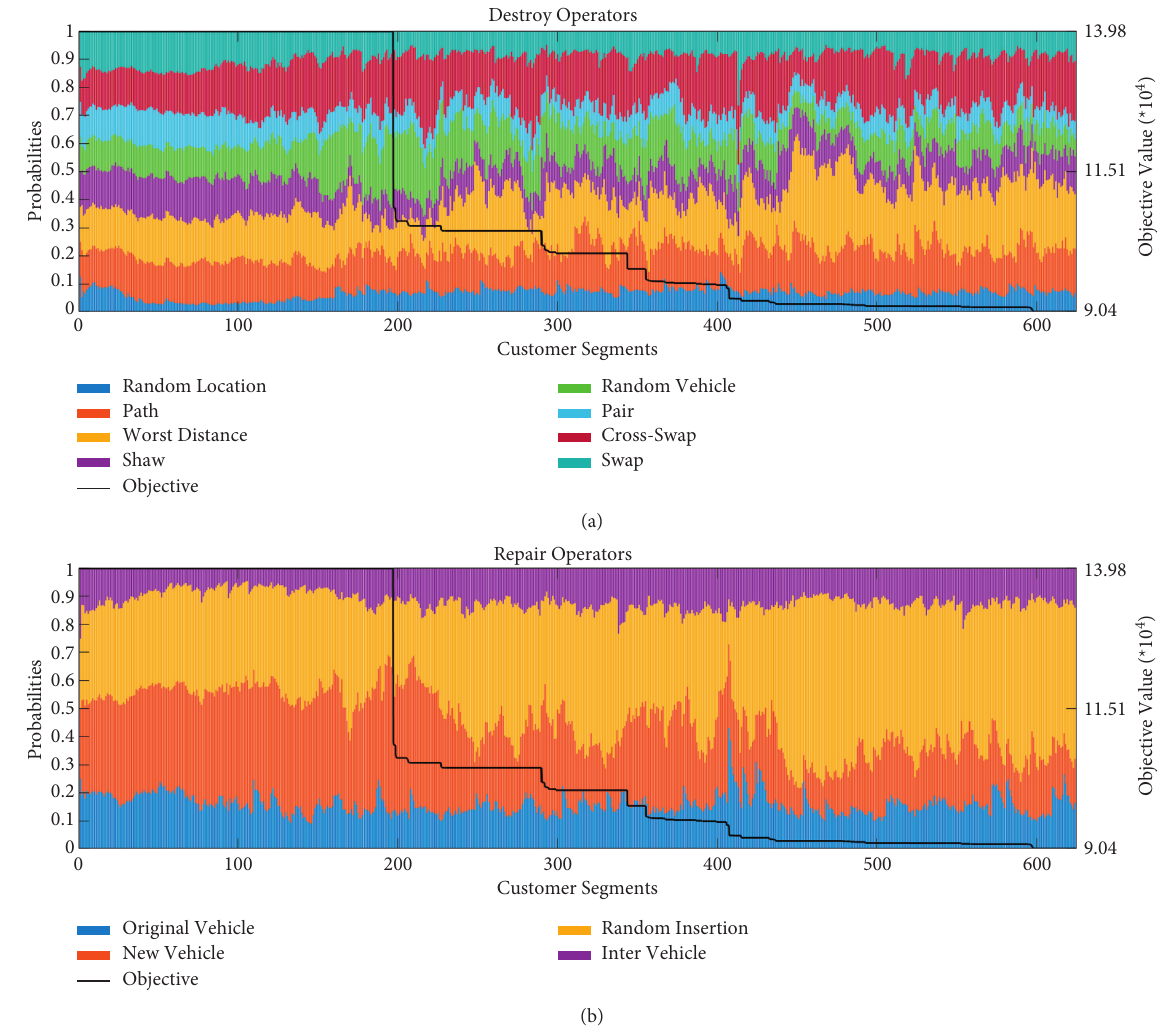
Figure 4: The probabilities of customer operators at each segment. (a) Customer destroy operators. (b) Customer repair